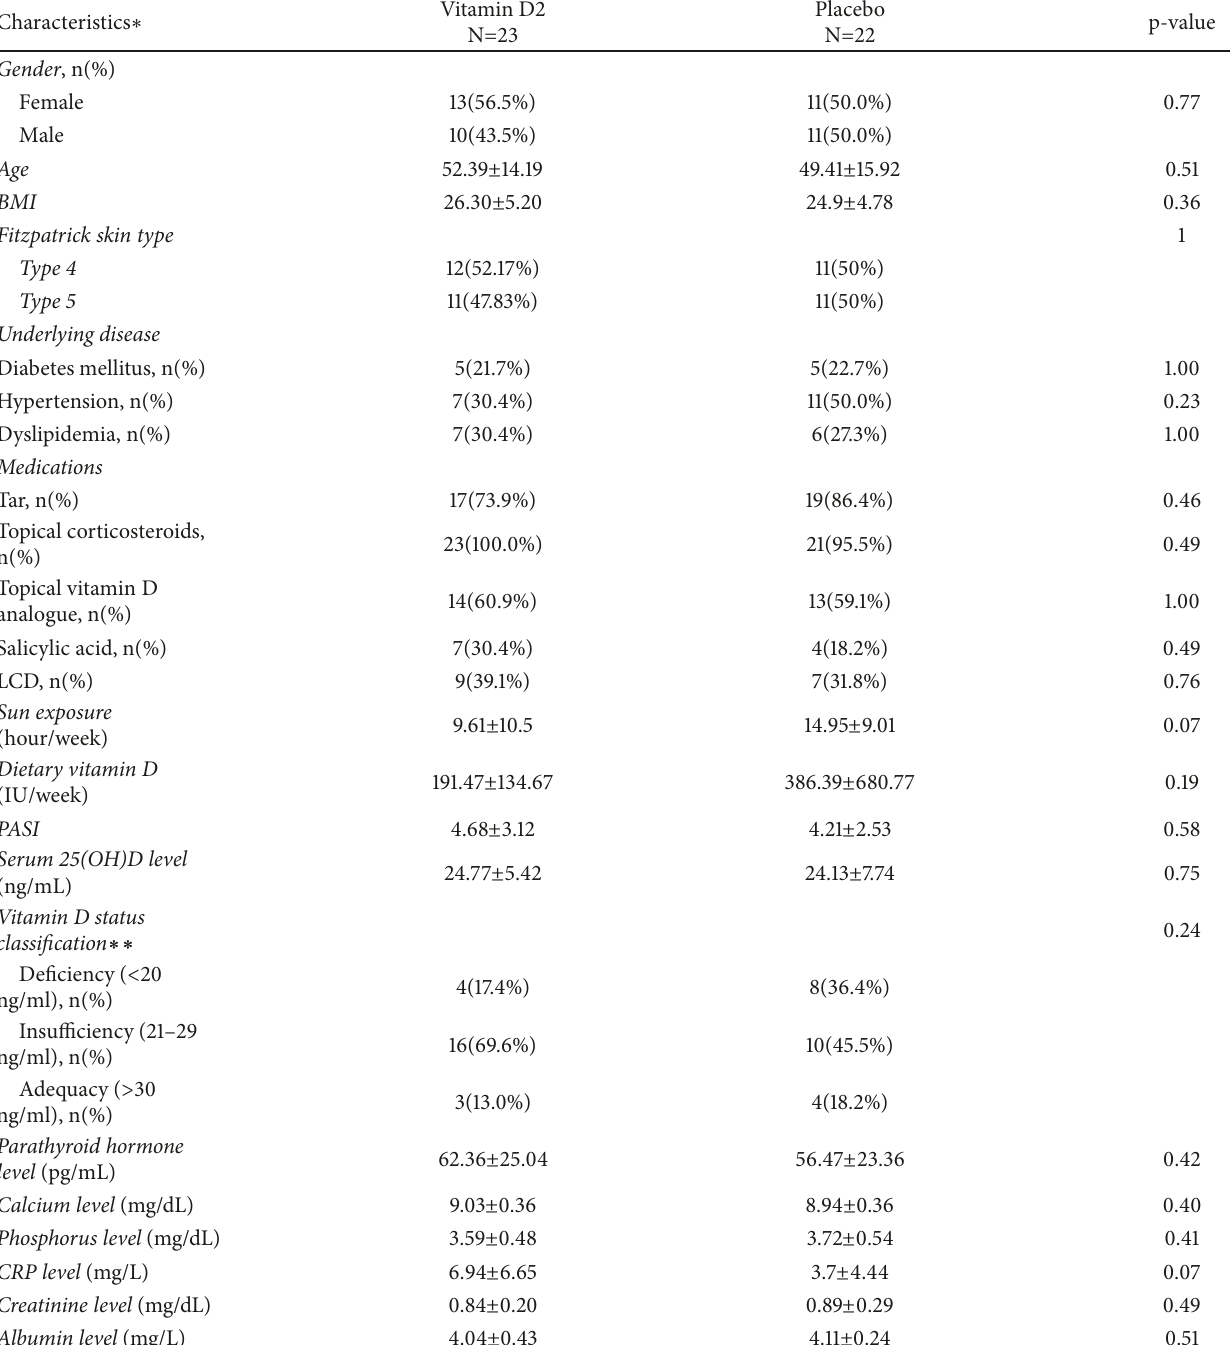
Table 1: Baseline characteristics between the vitamin D and placebo